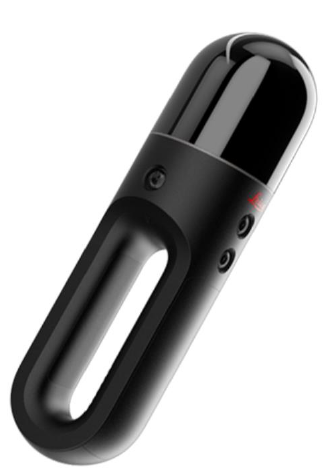
Figure 2 . Laser scanner Leica BLK2GO (Gefos a.s., 2022).